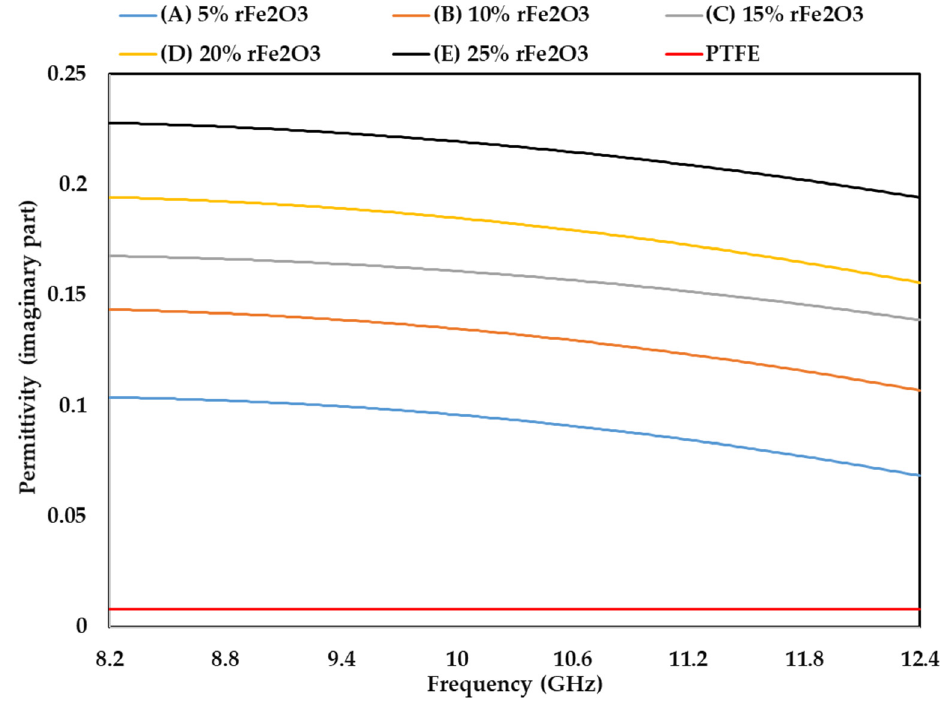
Figure 12. Variation in permittivity (imaginary part) of rFe 2 O 3 –PTFE nanocomposites using rectan- gular waveguide.